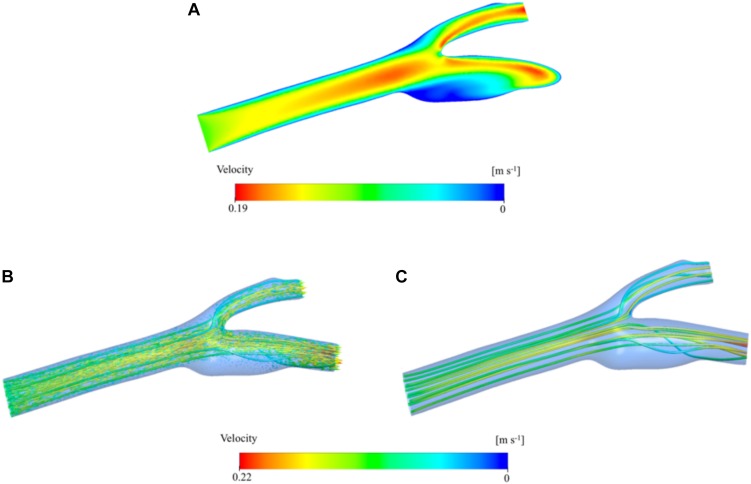
Velocity distribution color-coded by velocity magnitude. Contours are shown in the two-dimensional midplane in the axial direction (A). Velocity vector distribution in the three-dimensional artery geometry. The vectors are colored by the velocity magnitude and the vector size is scaled based on the velocity magnitude (B). Velocity streamlines are presented inside the 3D domain and colored by velocity magnitude (C).